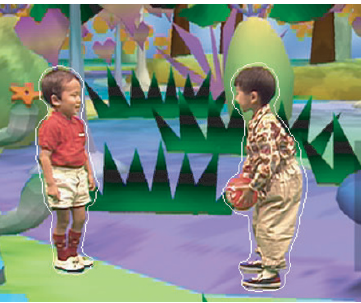
Figure 8: Segmentation result on Children sequence after auto- matic